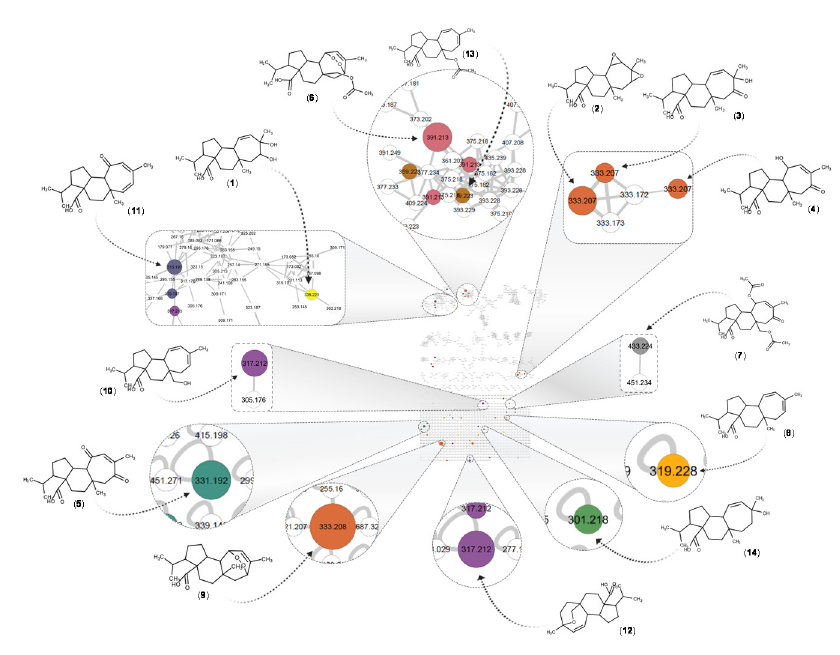
Figure 5. Molecular network in negative ionization mode for the Aa E. The displayed structures correspond to the fourteen putatively identified compounds (1–14, see Table 1). The identification of mulinic acid (9) was confirmed by isolation. Numbers inside the nodes correspond to the precursor mass for each feature, and the size is proportional to the intensity of each ion in the total ion current chromatogram of the extract. Colors represent the molecular formulas for all the reported compounds in the genus Azorella and Mulinum . The full MN and molecular formula color codes are shown in Supplementary Figure S2.